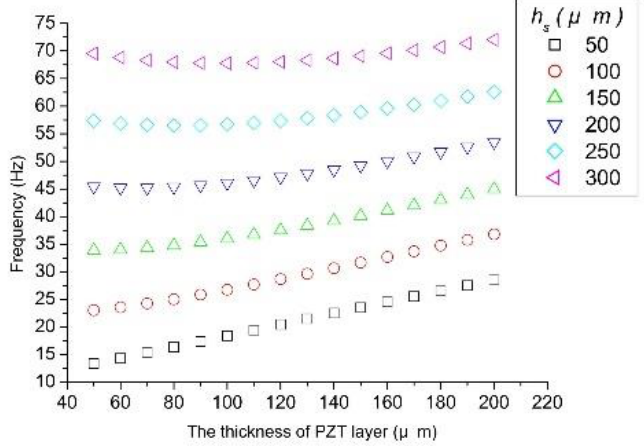
Figure 6. The analytic result for the thickness of the PZT layer vs. frequency.